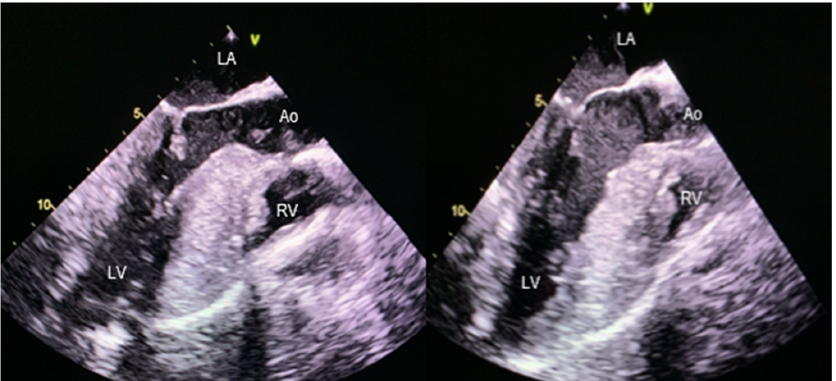
Figure 4. Preoperative ( left ) and postoperative ( right ) TEE showing the immediate results of septal myectomy and MV repair in obstructive HCM. Preoperative systolic anterior motion of the mitral valve is evident. A postoperative widening of the LVOT is noticed, not only by septal excision, but also by posterior relocation of the mitral